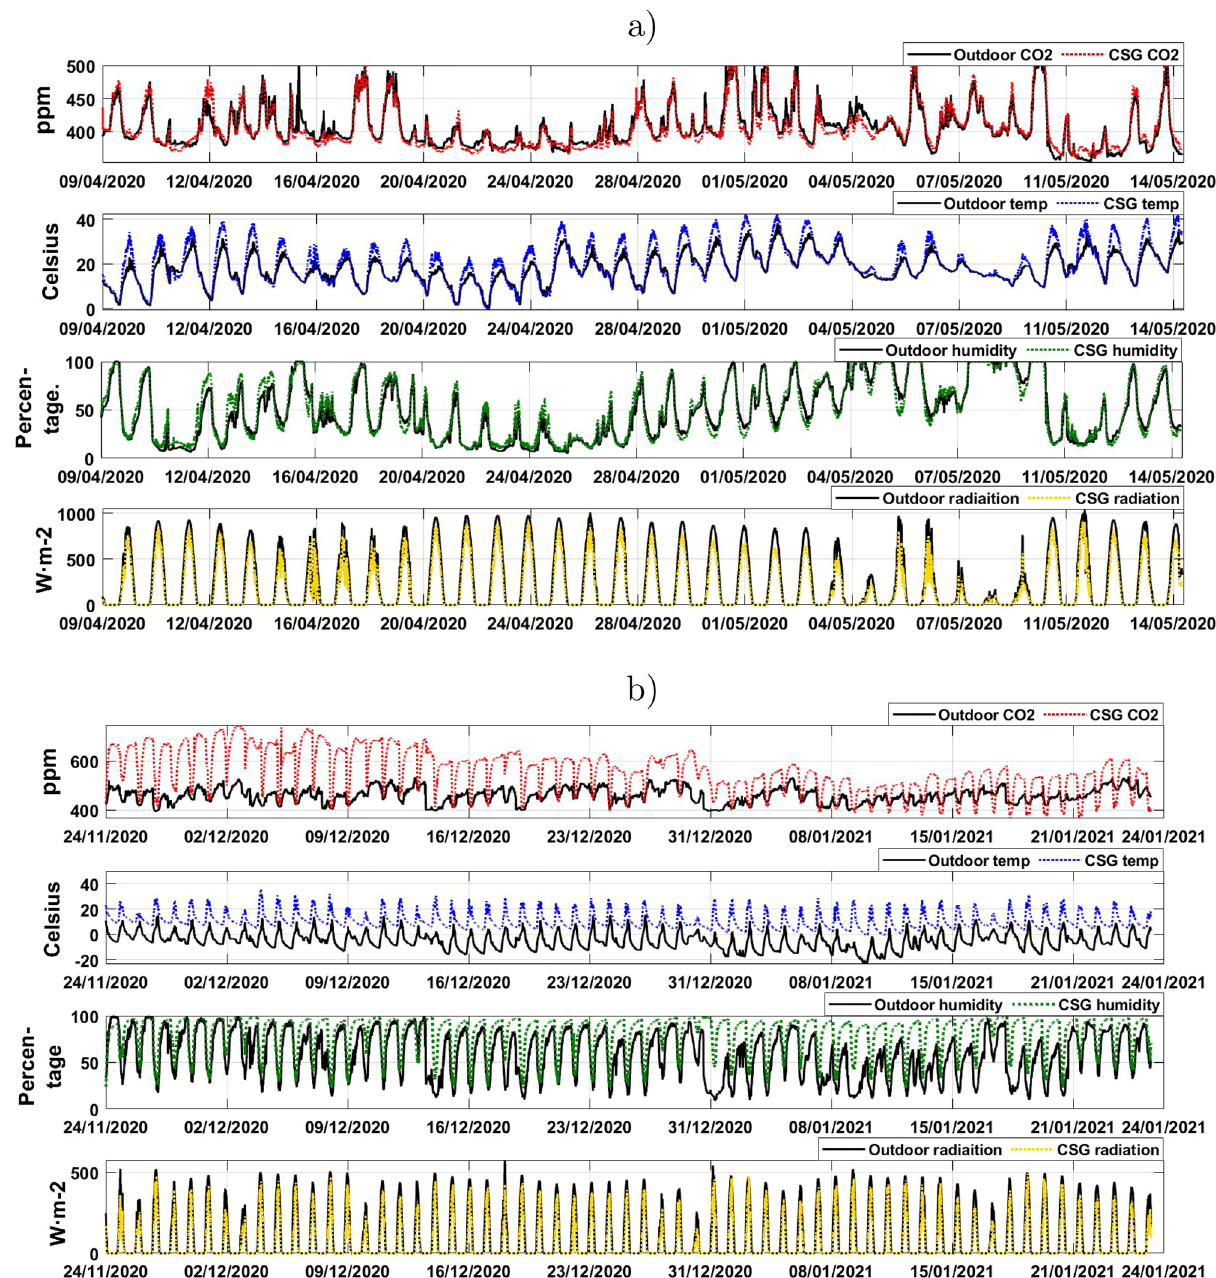
Figure 2. The collected data representing the environmental variation across the “warm” late spring and “cold” early winter experiments, ( a ) the collected data during experiment 1 for 35 days, ( b ) the collected data during experiment 2 for 60